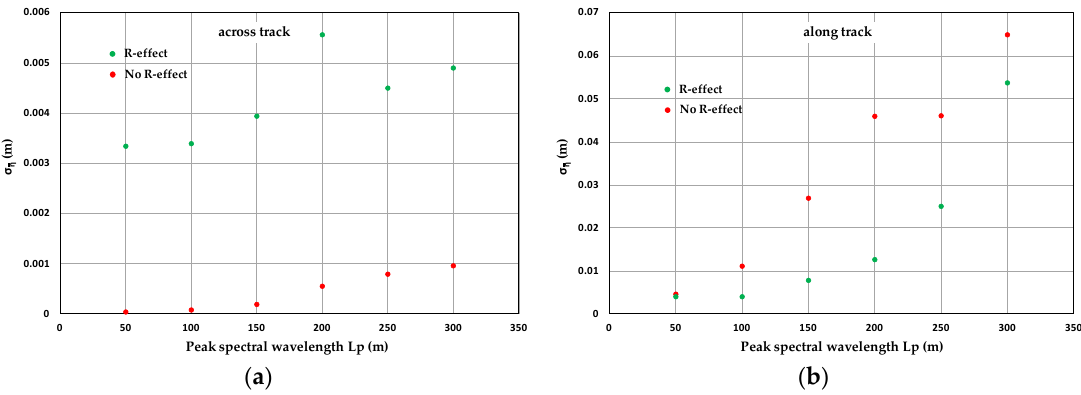
Figure 12. Standard deviation values σ η as a function of peak spectral wavelength Lp by considering (green diamonds), and by neglecting (red circles), R-e ff ect: ( a ) main wave direction across satellite track; ( b ) main wave direction along satellite track.